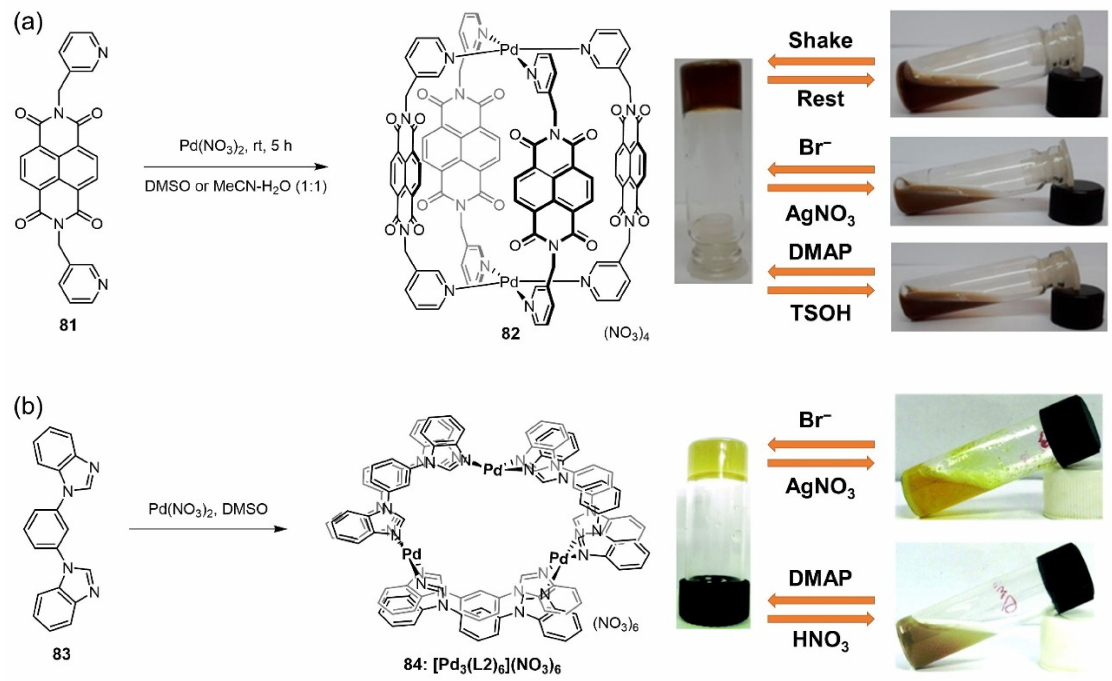
Figure 33. ( a ) Chemical structures of the metallic cage 82 and photographs of reversible stimuli- responsive phase transition of the gel 82 . Reprinted with permission from Ref. [107]. Copyright (2018), American Chemical Society. ( b ) Chemical structures of the trinuclear ring 84 and photographs of reversible stimuli-responsive phase transition of the gel 84 . Reprinted with permission from Ref. [108]. Copyright (2015), Royal Society of Chemistry.